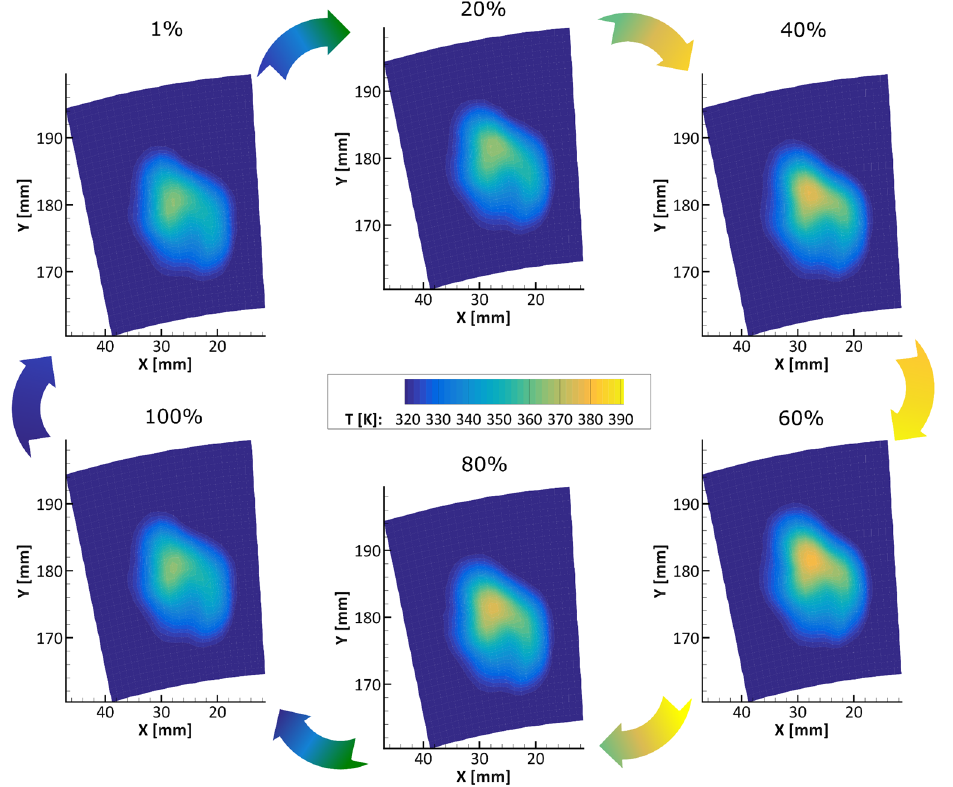
Figure 17. Entropy wave evolution at 110 Hz. Frames are at 1%, 20%, 40%, 60%, 80% and 100% of the period. The 1% frame is the top-left frame.